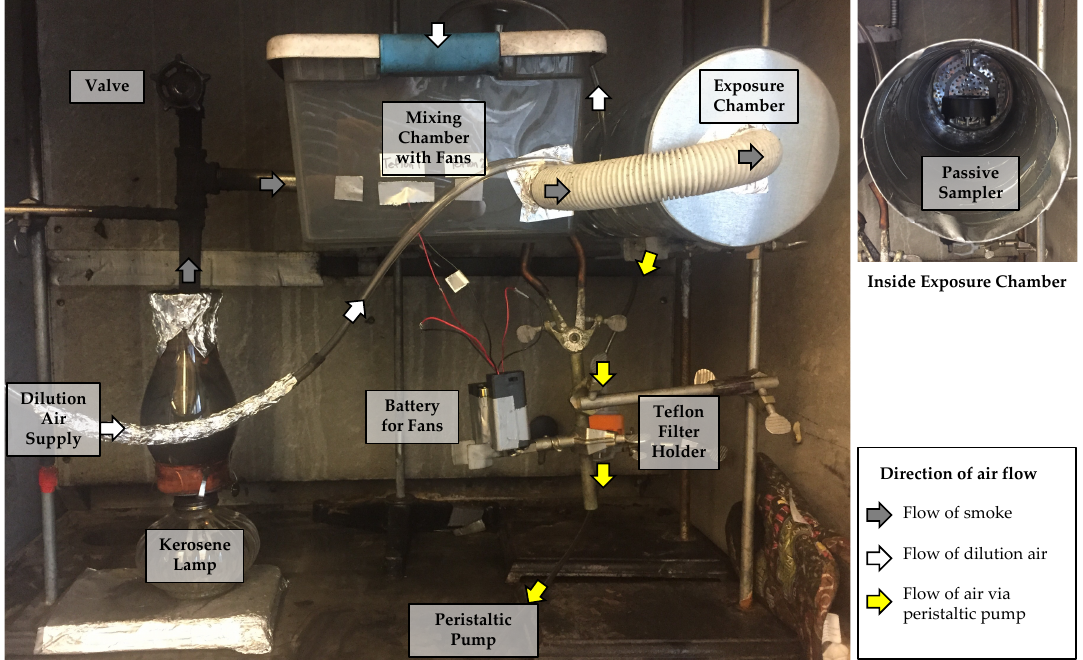
Figure A4. Design of exposure chamber with kerosene lamp as source of black carbon air